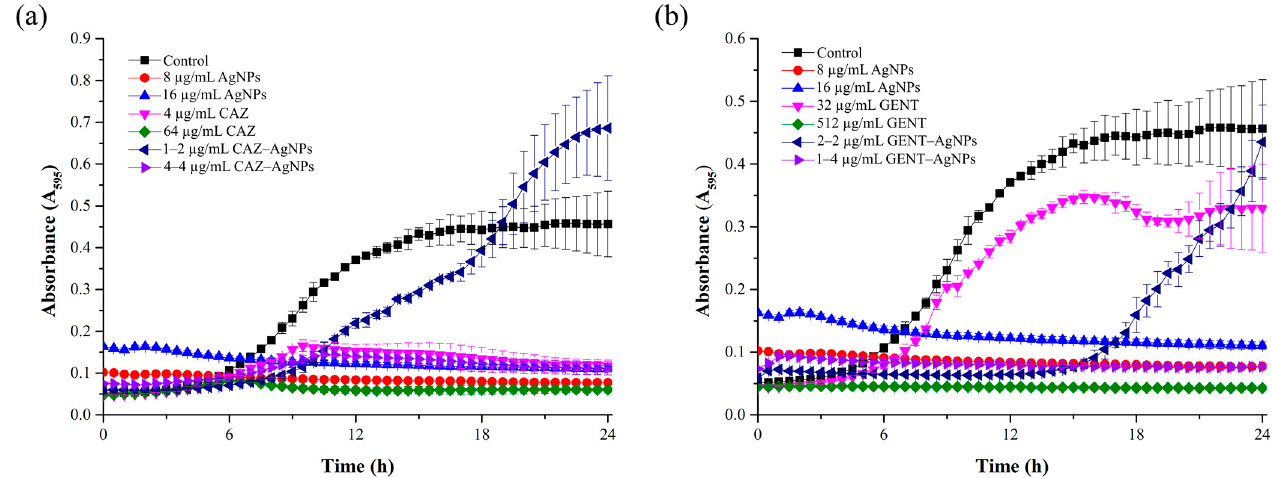
Figure 3. Bacterial growth curves of B. pseudomallei in the presence of different concentrations of AgNPs alone, the antibiotics alone, an antibiotic–AgNPs combination (( a ) CAZ; ( b ) GENT). The incubation of agents and bacteria was measured at 630 nm every 30 min for 24 h. The data represent the mean values ± SD (error bars) from two independent experiments carried out in triplicate.